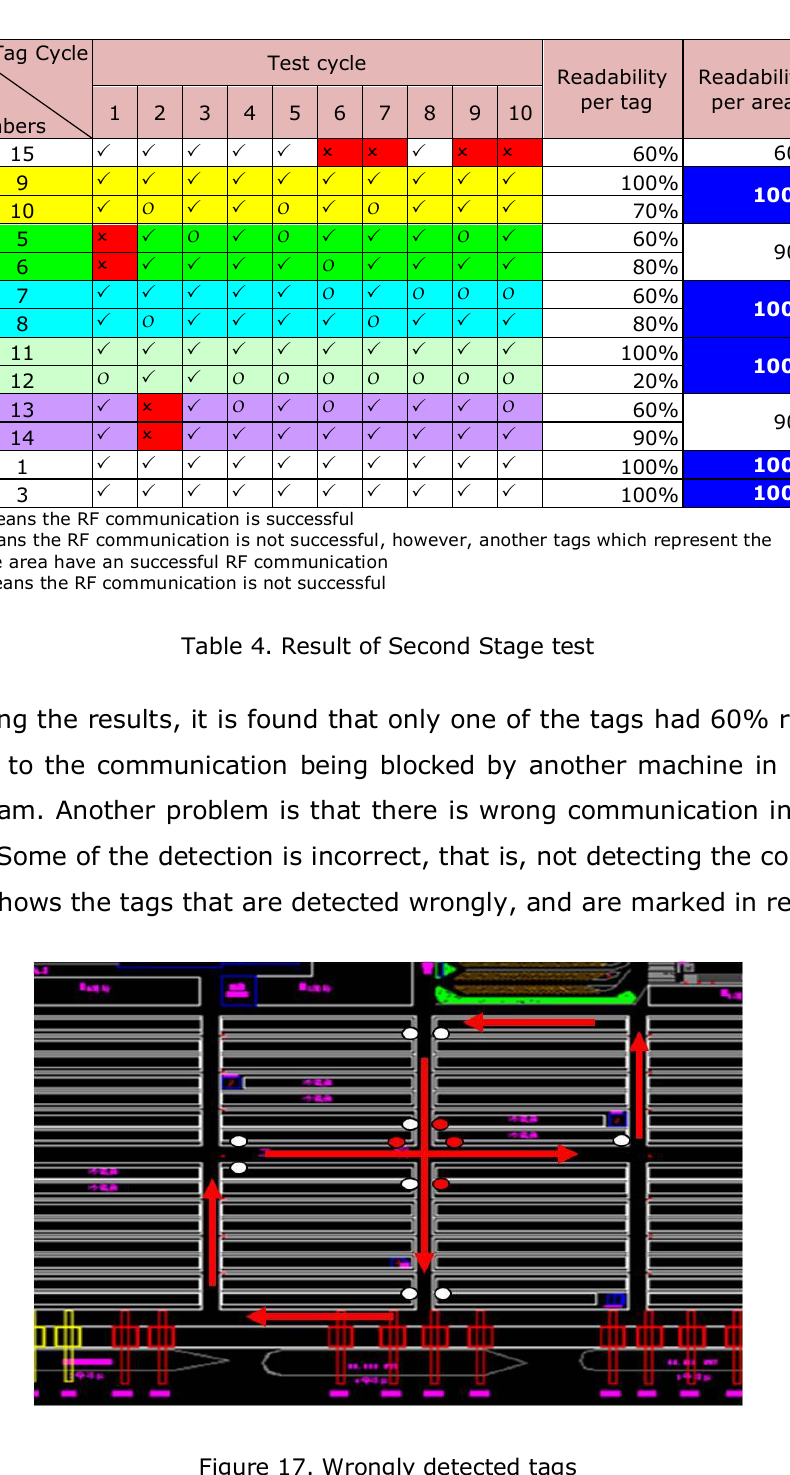
Figure 17. Wrongly detected